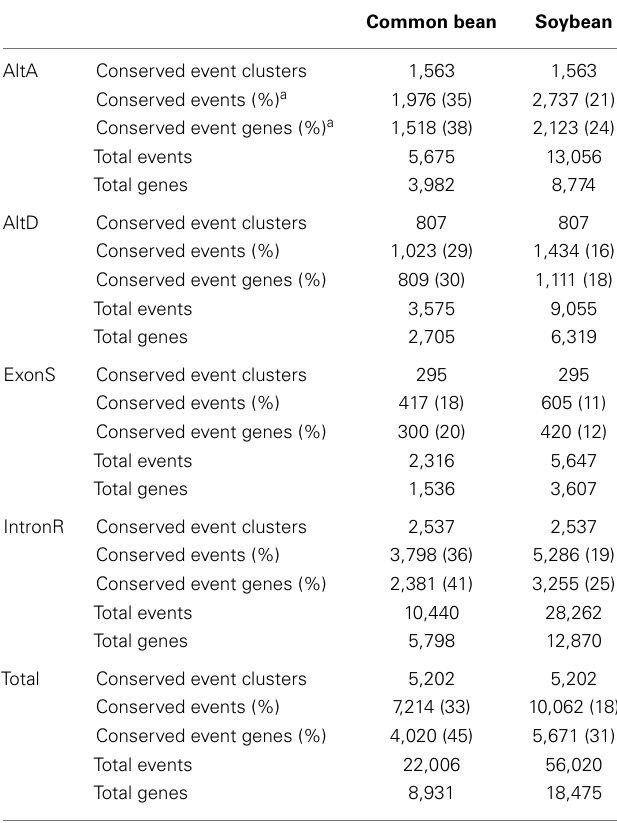
Table 2 | ConservedAS events between common bean and soybean at gene family level